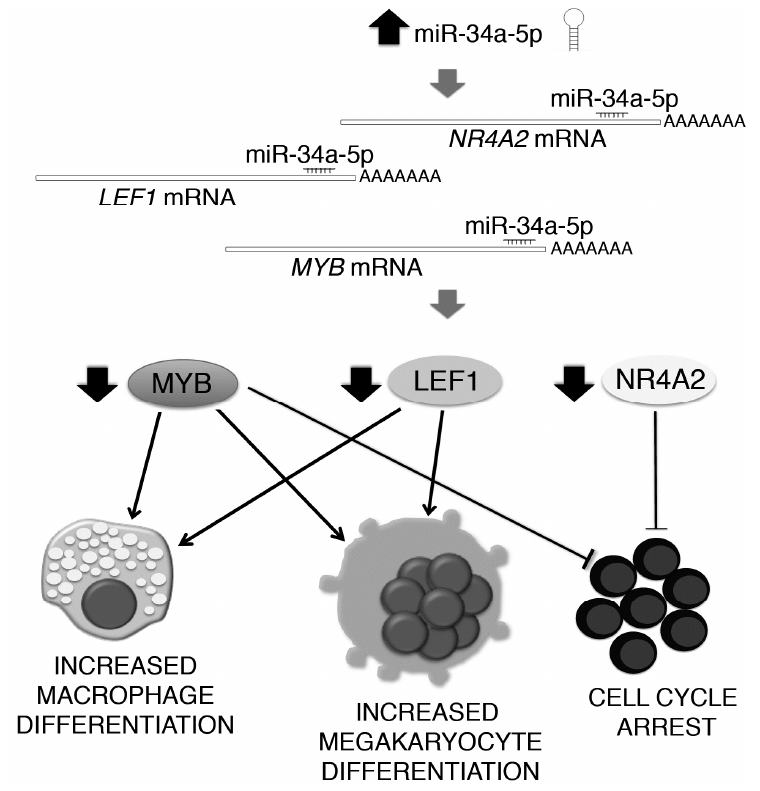
Figure 7. Schematic illustration of the mechanism through which miR-34a-5p affects the hematopoietic progenitor cells proliferation and commitment. miR-34a-5p targets MYB , LEF1 and NR4A2 transcripts in HPCs, therefore leading to the downregulation of MYB, LEF1 and NR4A2 proteins (ellipses). By targeting MYB, miR-34a-5p impairs the hematopoietic progenitor cells proliferation and enhances the megakaryocyte and macrophage differentiation. In addition, miR-34a-5p targets LEF1 mRNA for degradation. LEF1 downregulation further enhances the hematopoietic progenitor cells commitment towards the megakaryocyte and macrophage lineages, while the miR-34a-5p-driven downregulation of NR4A2 negatively interferes with cell cycle progression. Therefore, miR-34a-5p restrains hematopoietic progenitor cells proliferation and favours their commitment toward the megakaryocyte and macrophage lineages by targeting LEF1 and NR4A2, together with MYB.